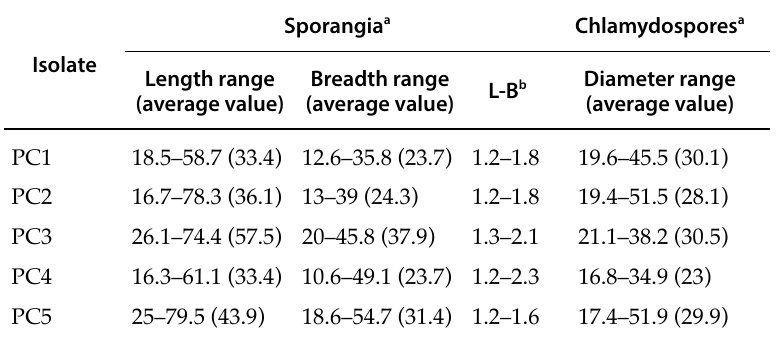
Table 1. Sizes (µm) of sporangia and chlamydospores of Phytophthora cinnamomi isolates from Platanus × acerifolia .